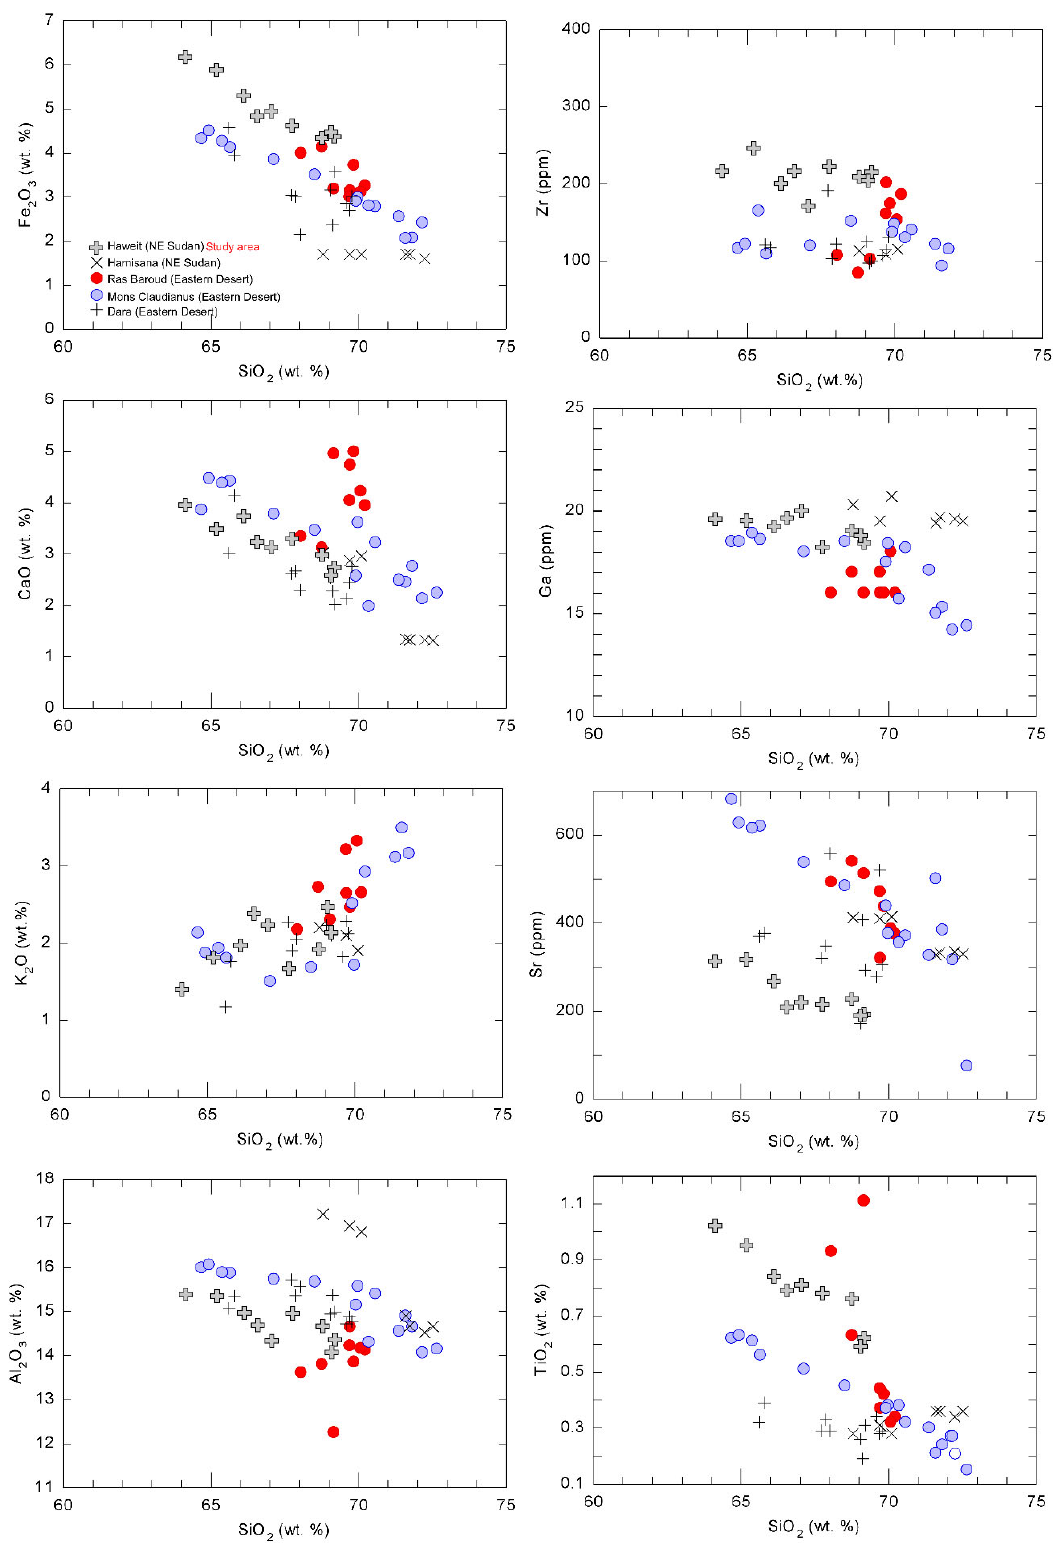
Figure 5. Harker variations of selected major (Fe 2 O 3 , CaO, Al 2 O 3 , K 2 O, and TiO 2 ) and trace (Zr, Ga, and Sr) elements vs. SiO 2 . The data of other granodiorite samples from various localities in the Nubian Shield, including Hamisana [13], Ras Baroud [41], Mons Claudianus [42], and Dara [43], are used for comparison.